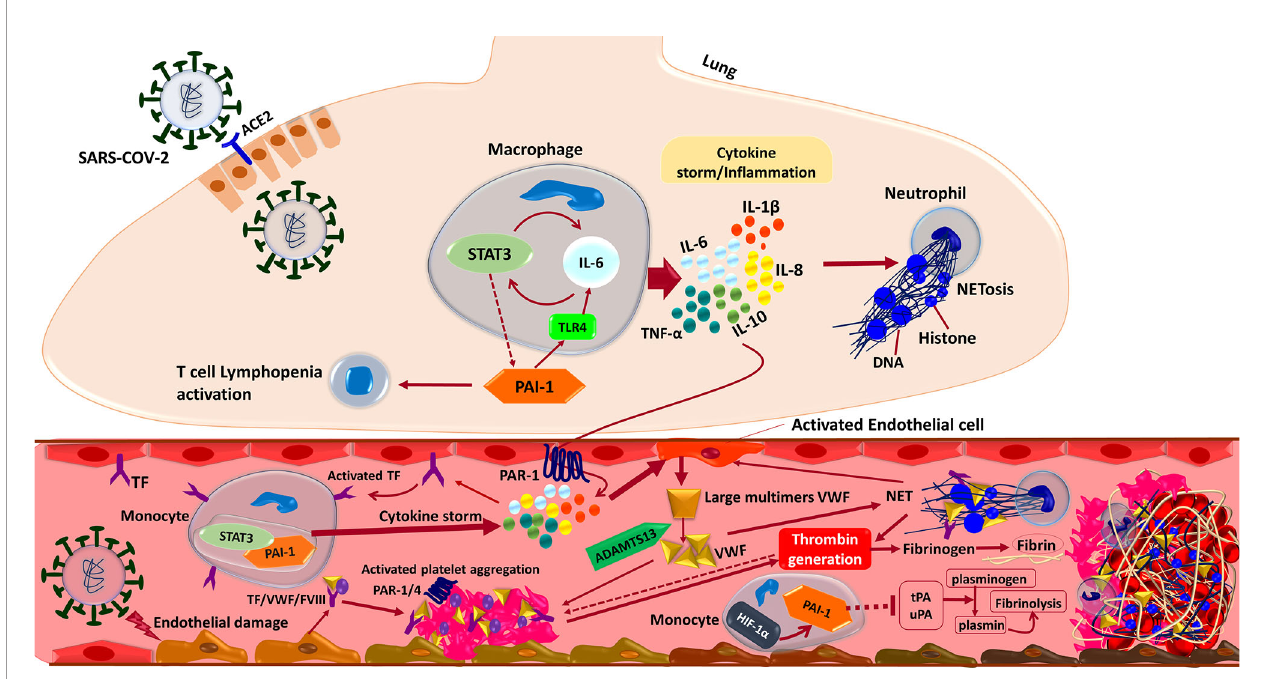
FIGURE 4 | Interactions between the components of the immune system and coagulation cascades that induce thrombosis in COVID-19. In brief, the SARS-CoV-2 infection triggers an in fl ammatory response in the alveolar lumen by macrophages and neutrophils. Overexpression of PAI-1 and its interaction with TLR4 induce the IL-6 expression and STAT3 activation in the lung of COVID-19 patients. Subsequent production of in fl ammatory cytokines such as IL-1 b , IL-8, IL-6, and TNF- a causes neutrophils to be recruited and release Neutrophil Extracellular Traps (NETs). NETs directly activate factor XII, thereby activating the contact-dependent clotting pathway. The PAR-1 receptor mediates cytokine-dependent Tissue Factor (TF) activation, which stimulates the STAT3/PAI-1 complex in blood ’ s monocytes and enhances in fl ammatory cytokine production leading to extrinsic coagulation cascade activation and thrombosis formation. Moreover, in fl ammatory cytokine in combination with the direct binding of SARS-CoV-2 to the endothelial cells triggers Von Willebrand Factor (VWF) secretion cleaved by ADAMTS13 to the regular size. Activated TF/VWF/FVIII complex in cooperation with NETs recruits platelets to adhere to endothelial surfaces and provoke intrinsic coagulation cascades. Altogether these events ultimately driving thrombin formation from circulating prothrombin, which cleaves fi brinogen to fi brin and stimulates thrombosis formation. Besides, suppression of endothelial enzymes and Plasminogen Activators (tPA/uPA) would aggravate the coagulopathy state by preventing effective fi brinolysis. Both tPA and uPA participate in the normal coagulation-plasmin- fi brin pathway, can be inhibited by PAI-1/HIF-1 a in severe COVID-19 patients with